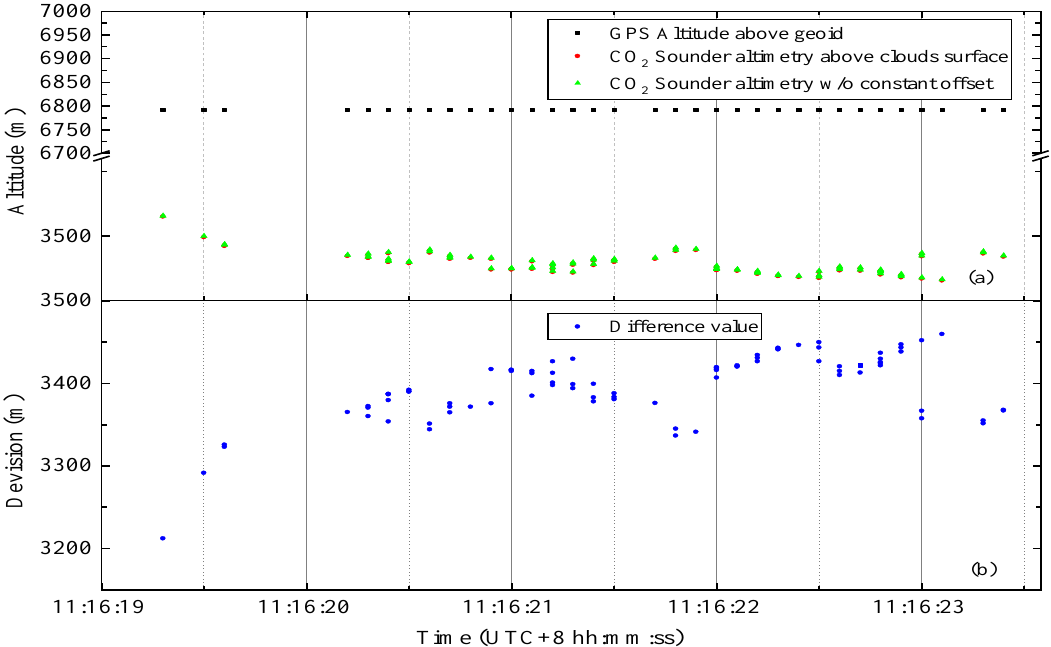
Figure 10. Result of processing a piece of continuous cloud data in the study area. ( a ) The black dots and green and blue points have the same meaning as those in Figure 9. However, the red points represent the CO 2 column length from the airplane to clouds. ( b ) The blue points represent the di ff erence between the CO 2 column length corrected to vertical at each point and the elevation of the airborne GPS.